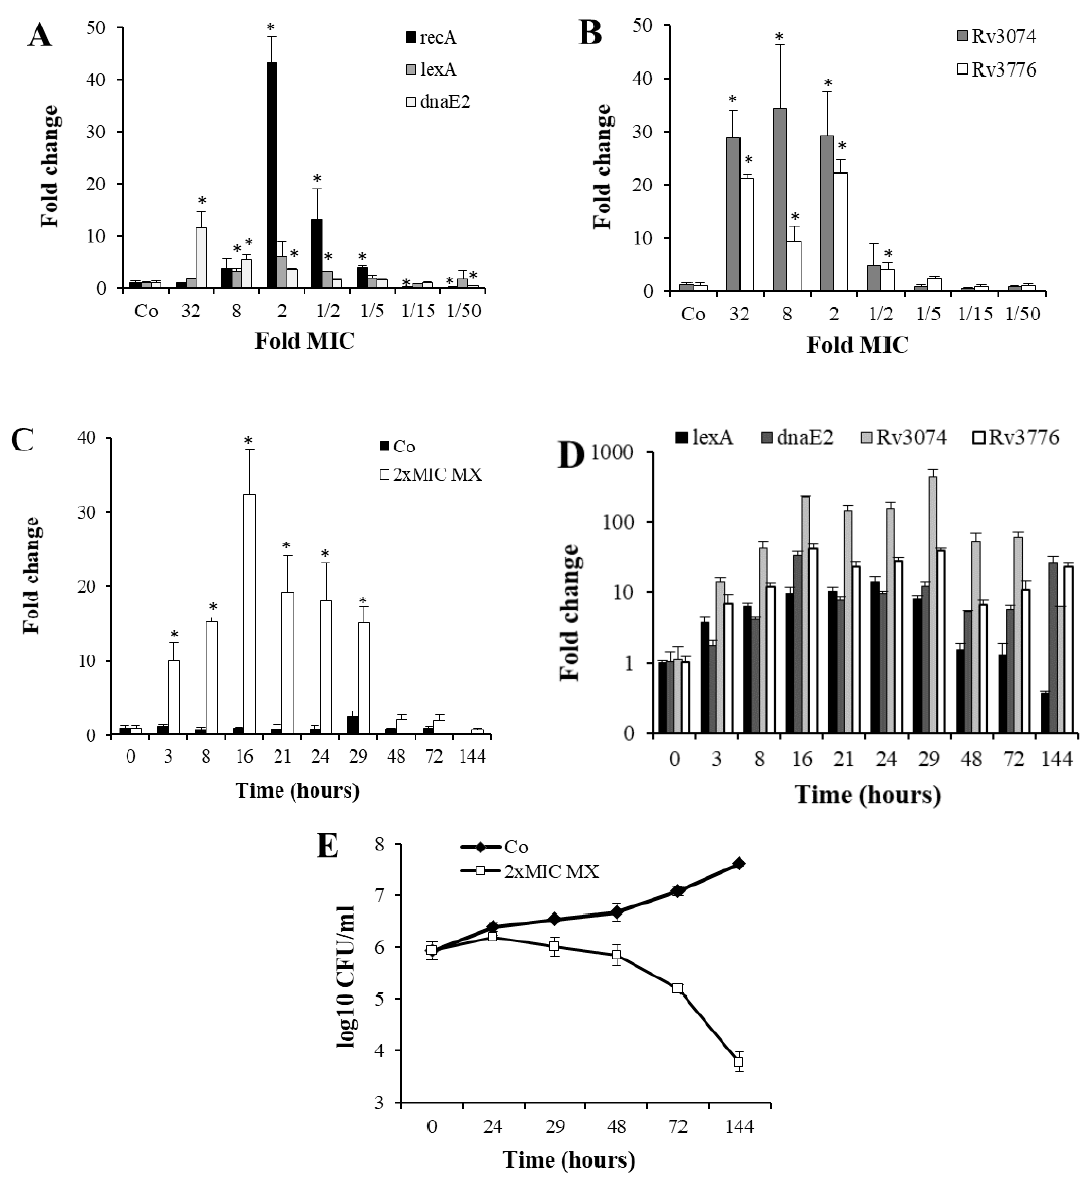
Figure 1. Dose- and time-dependent induction of the SOS response by MX. ( A ) Relative expression of recA , lexA and dnaE2 genes compared to untreated control cells, determined by qRT-PCR after overnight incubation of Mtb, with decreasing MX concentrations indicated as fold MIC values. ( B ) Expression of Rv3074 and Rv3776 genes in the same experiment as in panel A. ( C ) Time course of recA expression by qRT-PCR in Mtb cells incubated with 2 × MIC (0.25 μ g/mL) of MX. Gene expression was compared to control cells incubated without MX (Co). ( D ) Gene expression of lexA , dnaE2, Rv3074 and Rv3776 in Mtb cells incubated with 2 × MIC of MX in a time course experiment. All values were significantly different ( p ≤ 0.02) from time 0 except for dnaE2 at 3 h and lexA at 48 and 72 h. ( E ) CFU counts of untreated and 2 × MIC of MX-treated Mtb cells. A representative experiment of each assay is shown. Error bars show standard deviations, (*) indicates p ≤ 0.02 compared to each appropriate control.